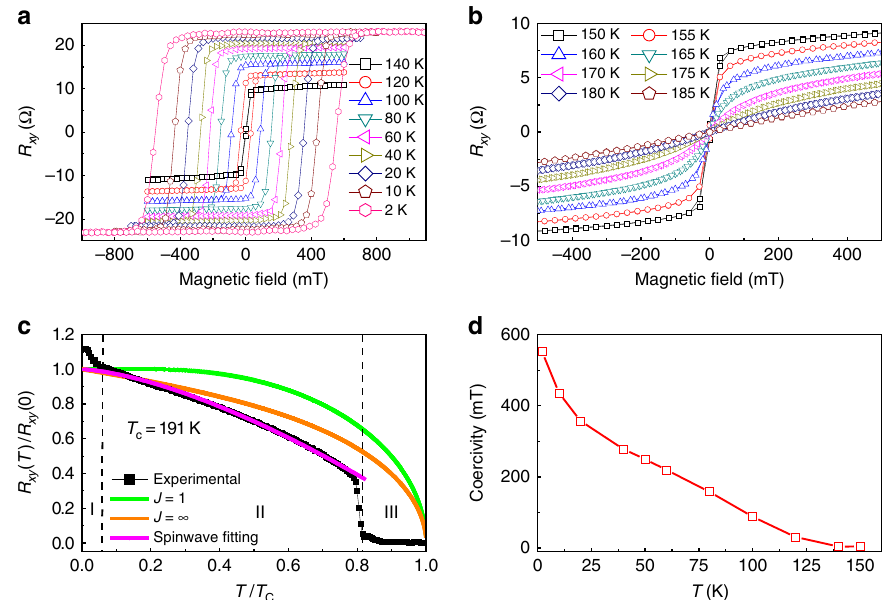
Fig. 3 Anomalous Hall effect measurements performed on 10.4 nm thickness FGT device. a R xy ( B ) loops in the temperature regime from 2 to 140 K in which the FGT nano fl ake shows ferromagnetic properties. b R xy ( B ) curves in the temperature regime from 150 to 185 K. The FGT nano fl ake shows zero coercivity and remanence when T > 150 K. c Normalized R xy ( T ) curve and three fi tting curves based on the mean fi eld theory J = 1, J = ∞ , and the spin wave theory, respectively. Three magnetic regimes exist from 2 K to T C = 191 K. Regime I (2~10 K) is an unknown phase requiring further investigation. Regime II (10~155K) is a hard ferromagnetic phase. Regime III (155~191 K) is a phase with zero coercivity and remanence. d The temperature dependence